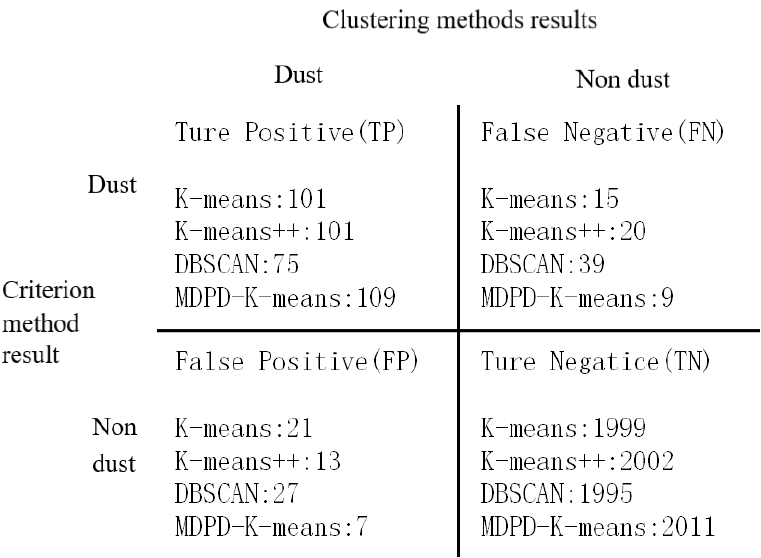
Figure 5. Confusion matrix of case number by using clustering method and criterion method.